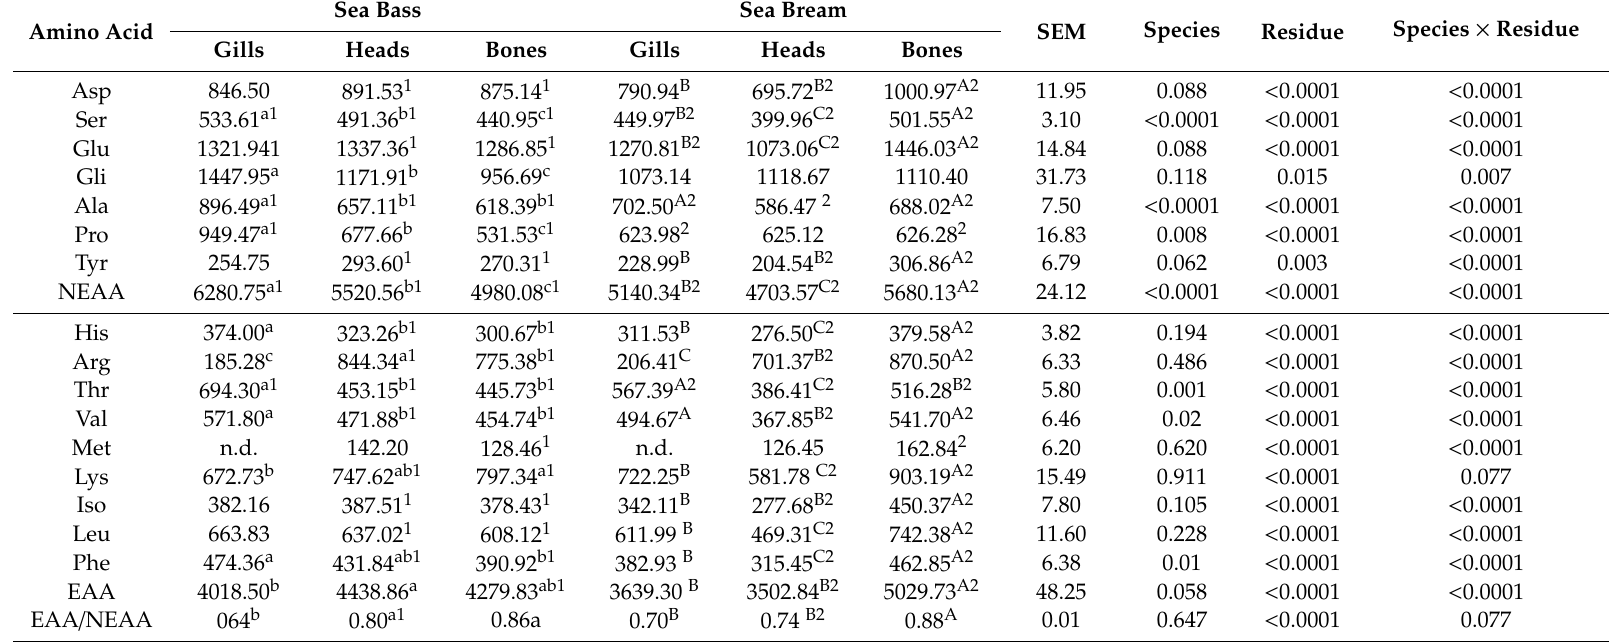
Table 2. Amino acid profile of residues (gills, heads, and bones) from sea bass and sea